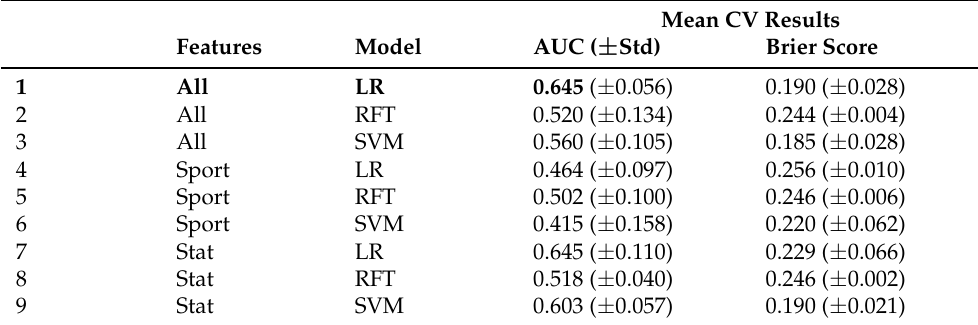
Table 5. Results for the models trained using only the data from females for different sets of features and algorithms. Either all features (All), only the sports-specific features (Sport), or only the statistical features (Stat) are used. The reported values are a mean across the scores obtained for each of the six CV folds.